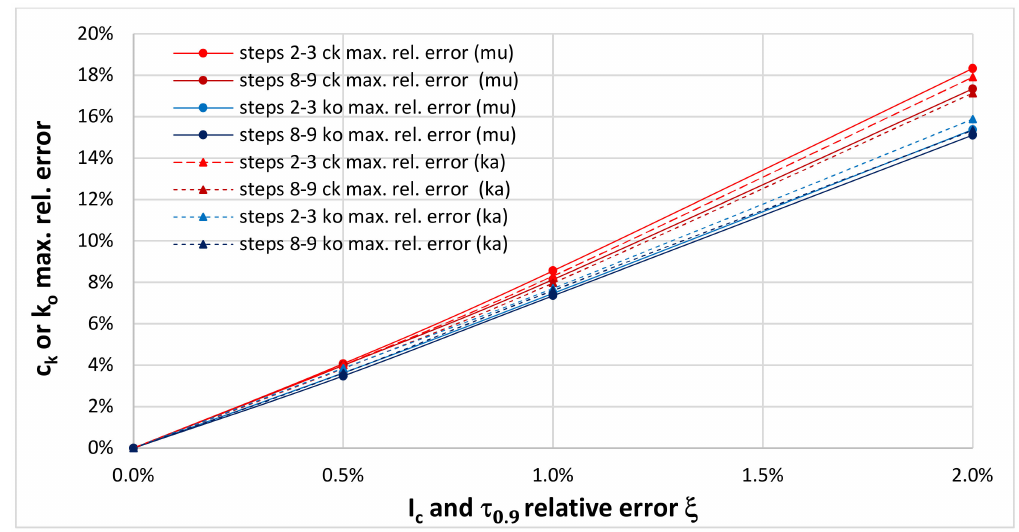
Figure 9. Maximum deviations of k o and c k as a function of ξ